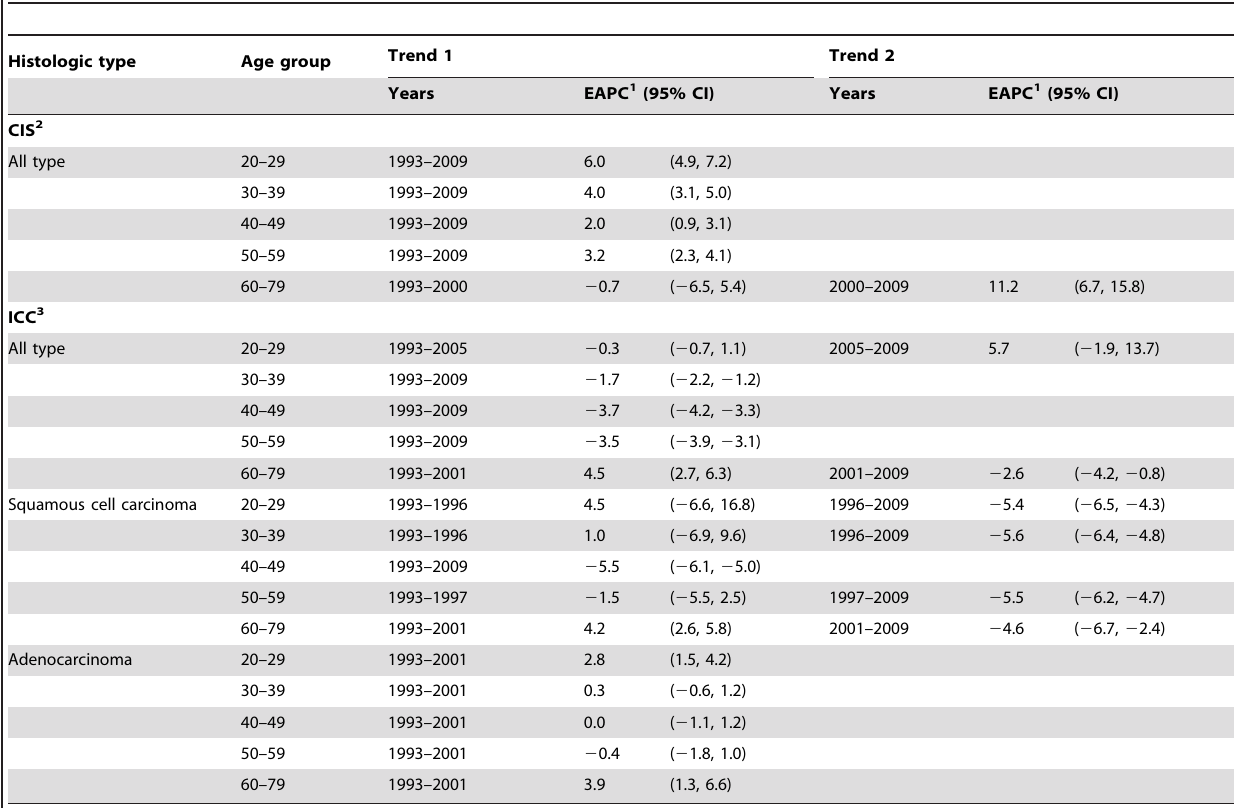
Table 3. Joinpoint regression of incidence of in situ and invasive cervical cancer by histologic type and age group in Korea, 1993–